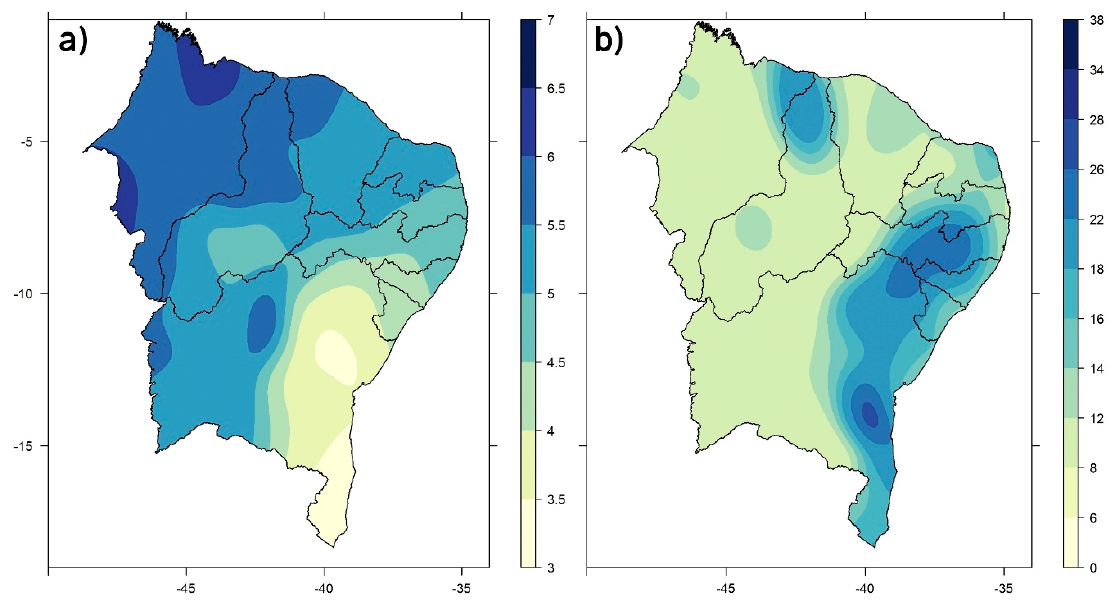
Figure 4. a) Average and b) Maximum duration (months) of drought in NRB during the